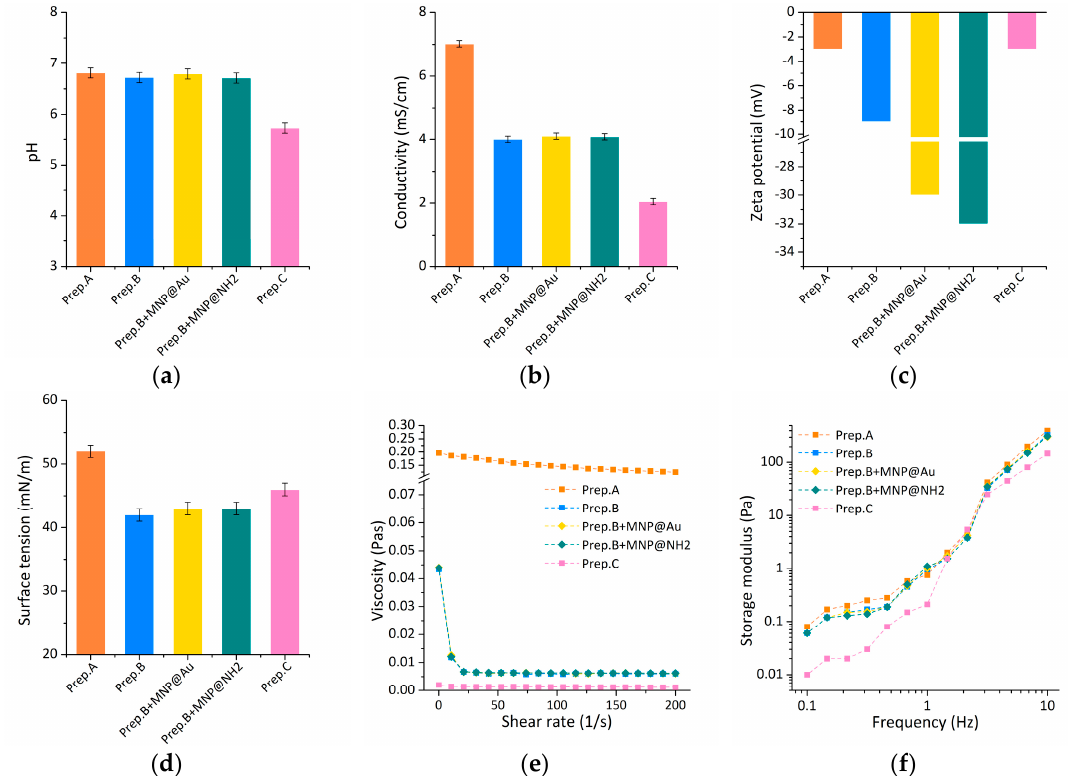
Figure 7. Physicochemical and rheological characteristics of tested artificial saliva preparations: ( a ) pH, ( b ) conductivity, ( c ) zeta potential, ( d ) surface tension, ( e ) viscosity, and ( f ) viscoelasticity. Shown data refer to average-values of five measurements.